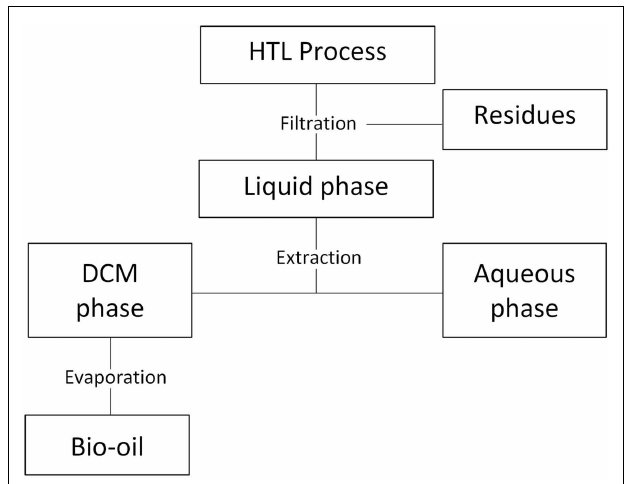
FIGURE 1 | Hydrothermal liquefaction process and product separation .